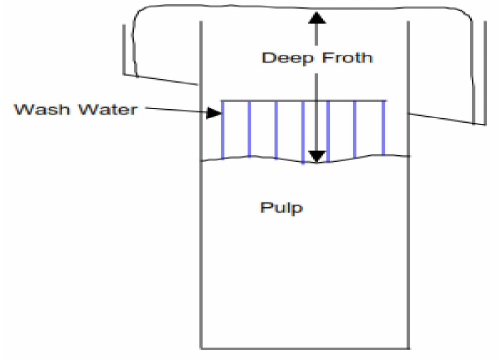
Figure 10. Column cells with a wash water system